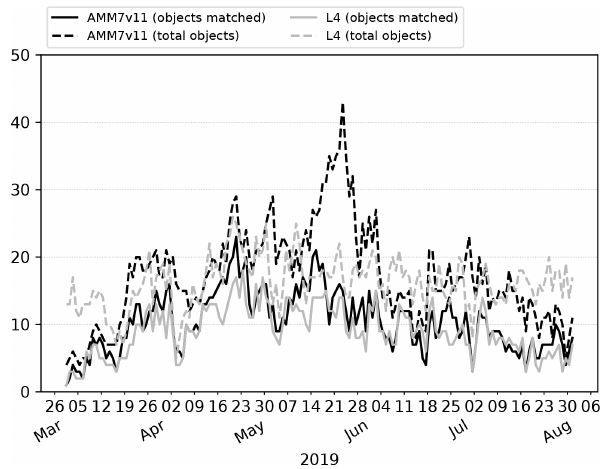
Figure 8. Time series of the number of matched and total objects per day from MODE comparing AMM7v11 analyses (black) with L4 satellite product (grey). Objects are identified using a threshold of 2.5mgm − 3 . Total object numbers for the season are 2341 for the L4 satellite product and 2632 for AMM7v11.